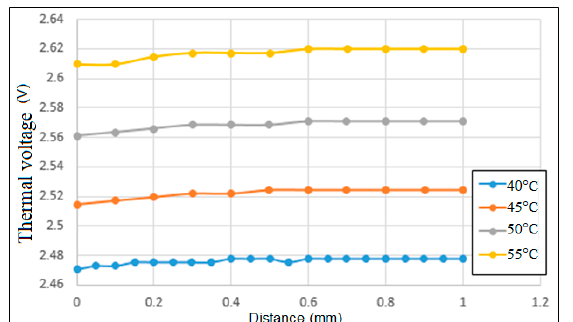
Figure 11. Correlation between thermal voltage and sensing distance for working temperatures in range of 40~55 °C.